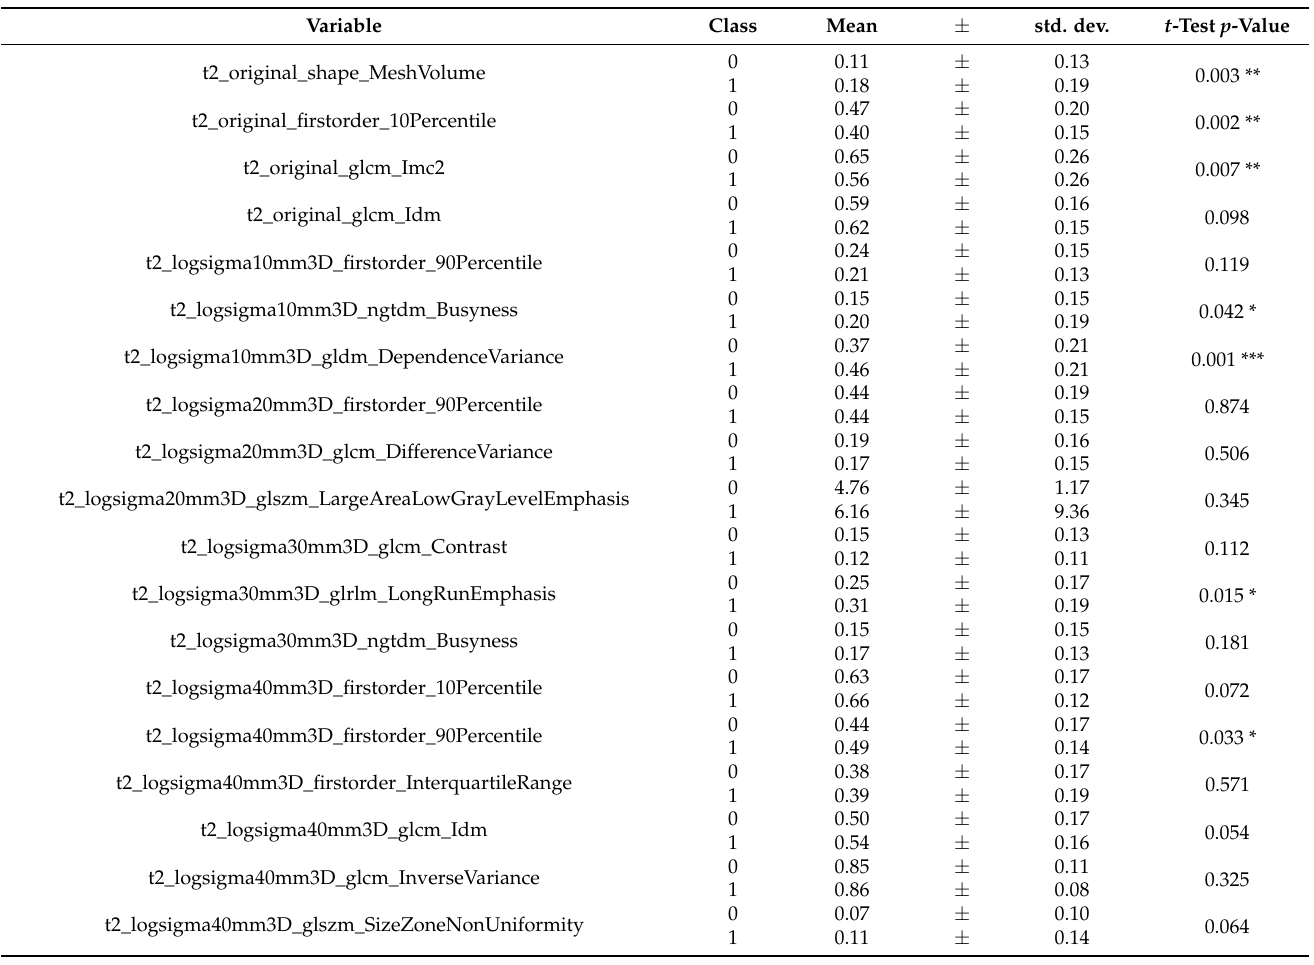
Table 1. Descriptive statistics for the 60 radiomic variables and comparison between significant (0) and non-significant (1) lesions. Feature names are structured as follows: “MRI sequence”, “image type (original or filtered)”, “feature class”, “feature name”, each separated by an